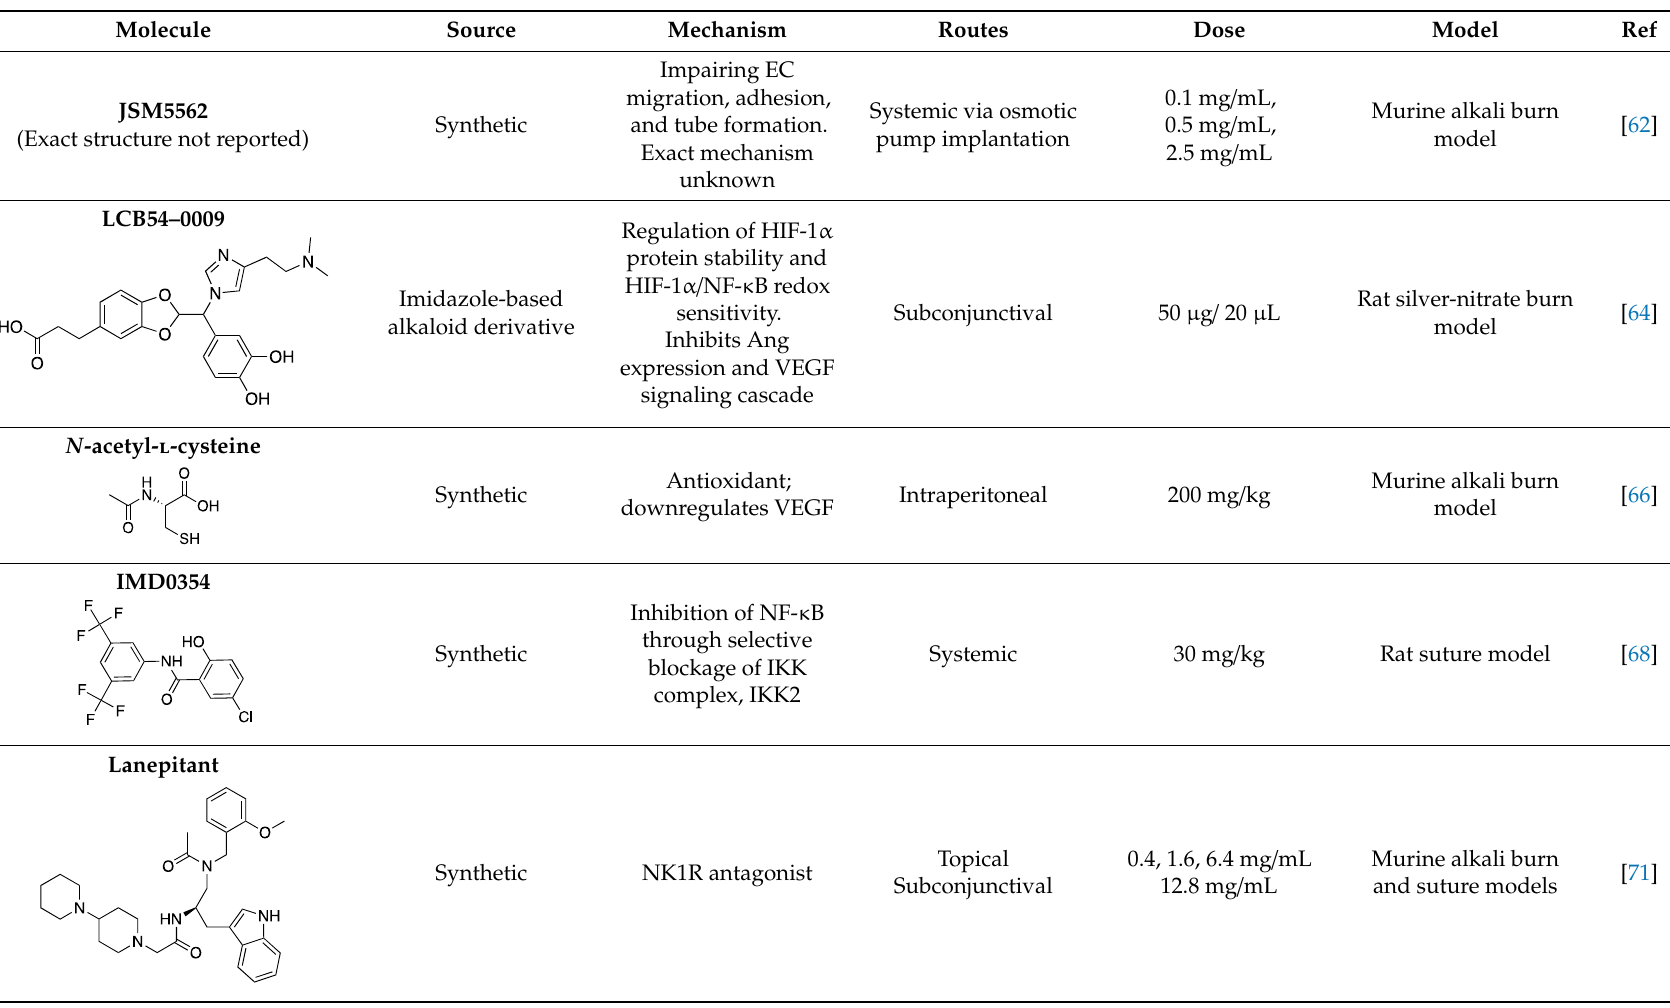
Table 3. Other synthetic small molecules tested in CoNV